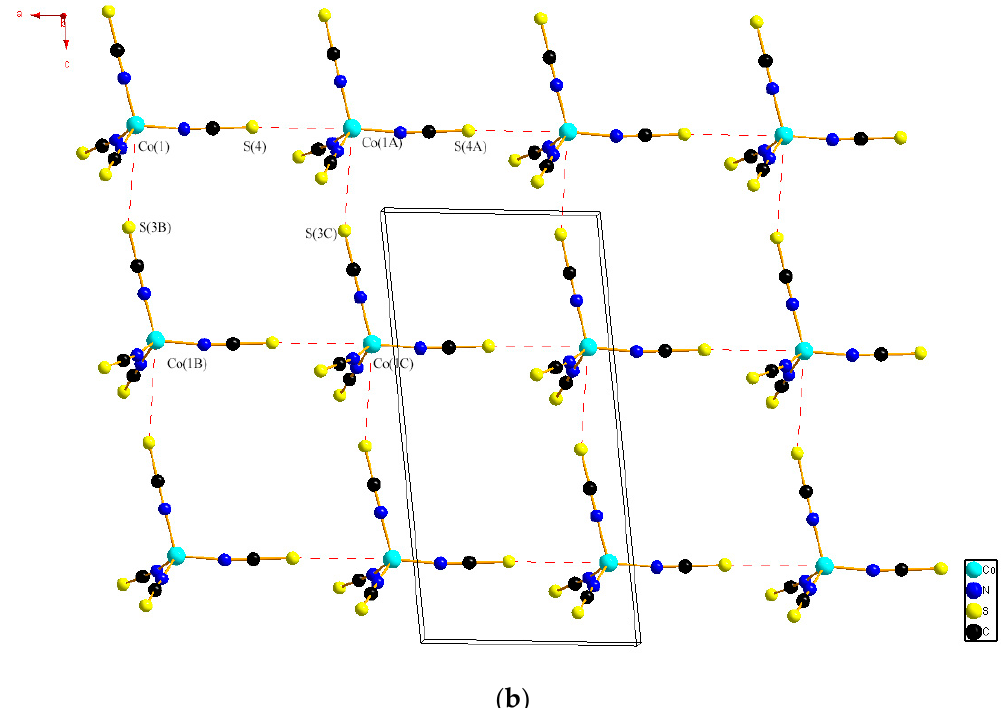
Figure 1. ( a ) Oak Ridge Thermal Ellipsoid Plot (ORTEP) plot (30% probability ellipsoids) showing the molecule structure of 1 . ( b ) The 2D layered structure of [Co(NCS) 4 ] 2 − through S···Co interaction between anions for 1 .